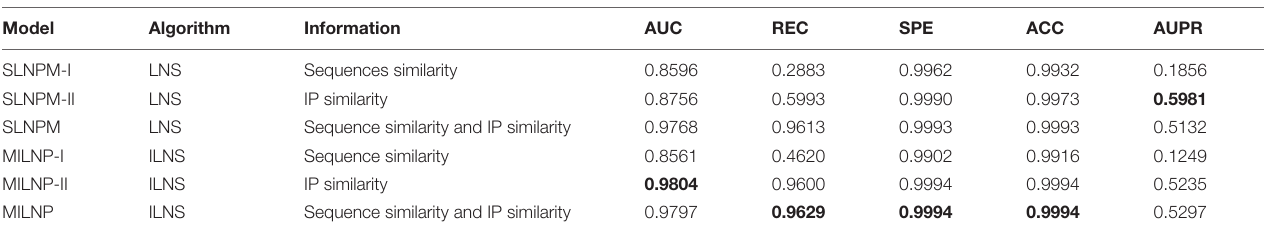
TABLE 3 | Performance of models with combinations of different algorithms and information.